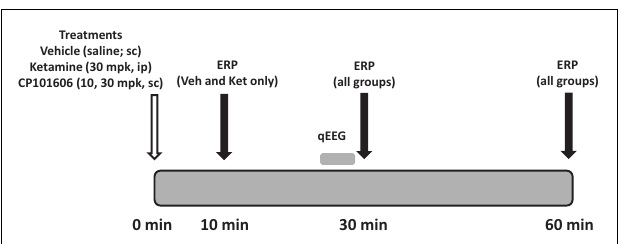
FIGURE 3 | Schematic indicates protocol timeline .Treatments were made in a randomized cross-over design on 16 subjects at time zero. EEG was collected at three time points